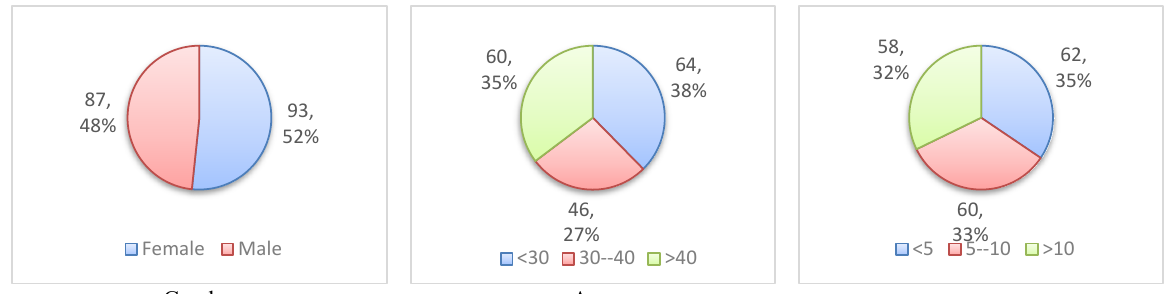
Fig. 2 demonstrate the summary of the personal characteristics of the participants.